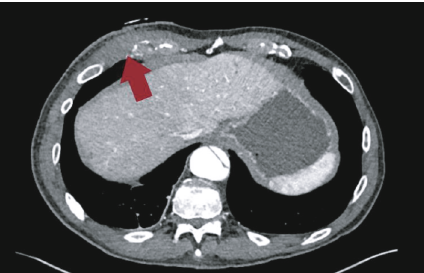
Figure 1: CT Scan showing fl uid collection (red arrow).